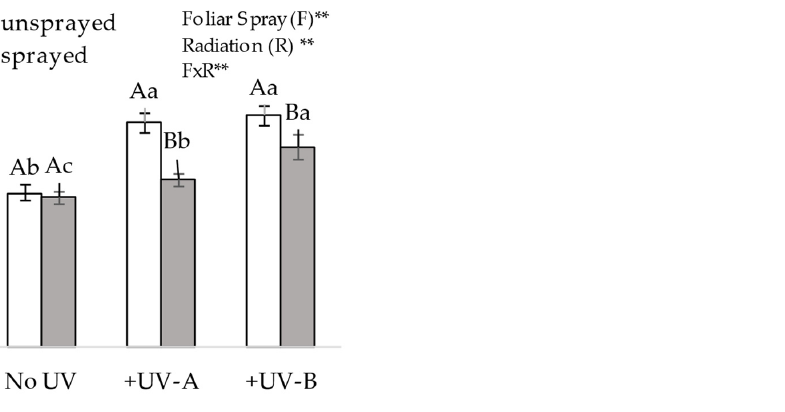
Figure 1. Effect of UVR regimen and/or mitigating treatments on malondialdehyde content. FW (fresh weight). Same uppercase letters within sprayed/unsprayed (intra-treatment) or the same lowercase letters across UVR regimens (inter-treatment) indicate no difference using Tukey’s test ( p < 0.05). ** denote significance among foliar spray and UV radiation, according to the Tukey test (ANOVA).